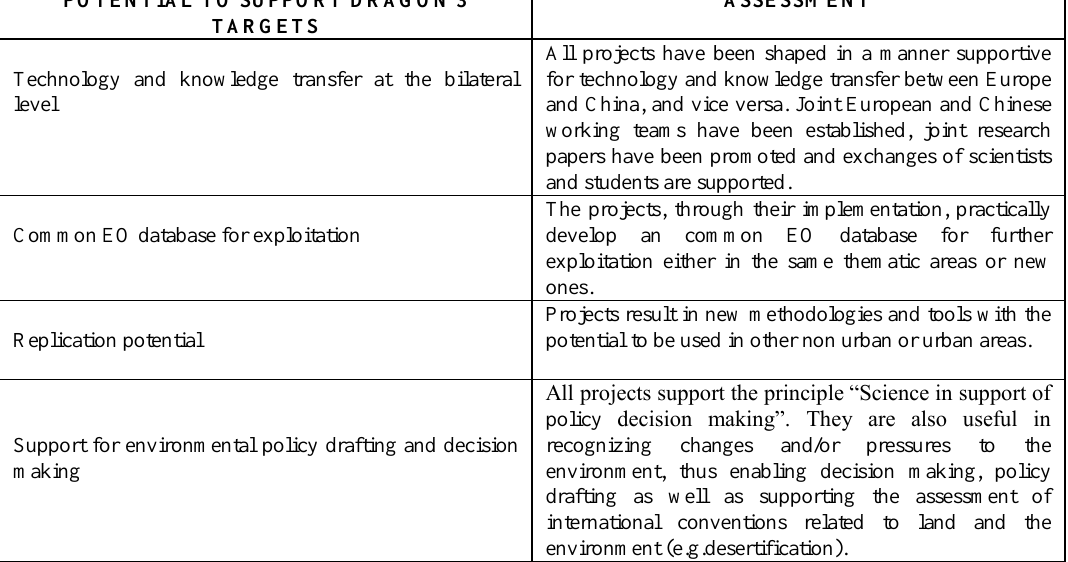
Table 3. An assessment of the potential of the projects to support DRAGON 3